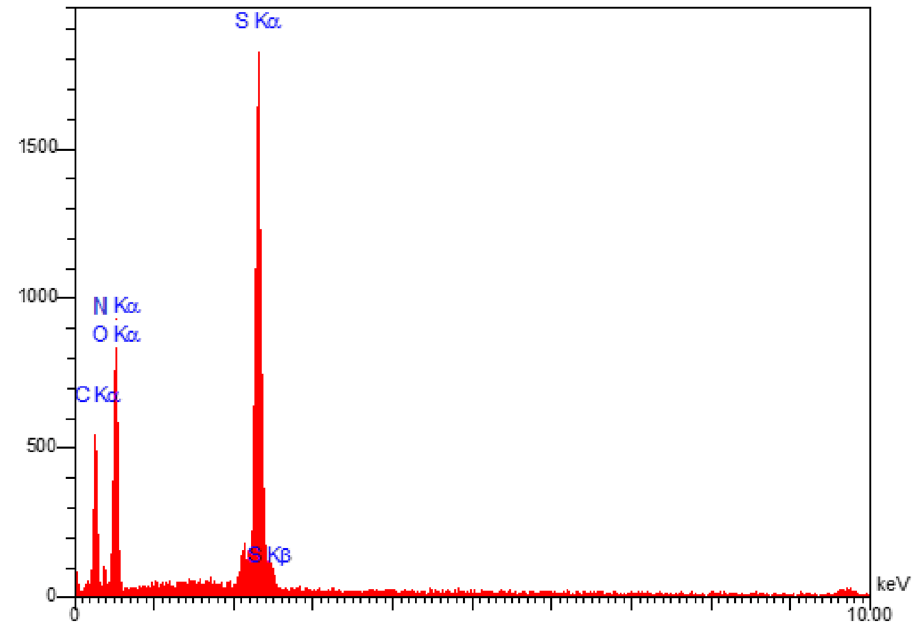
Fig. 3 EDX analysis of [ N -CH CO H-3-Pic] + HSO 4− 2 2